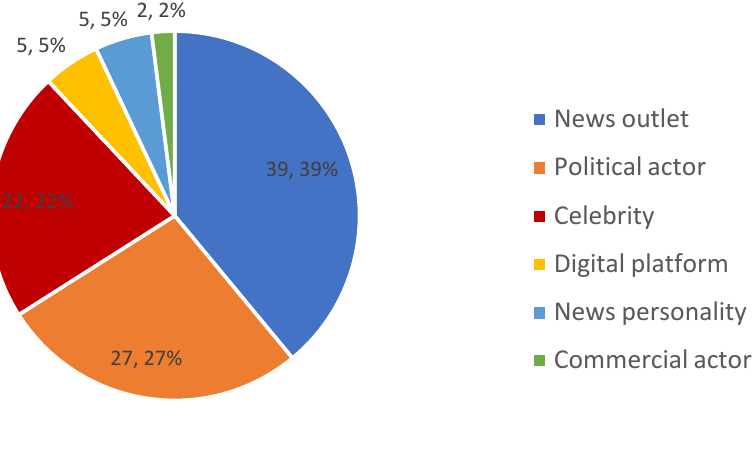
Figure 1: Type of User for the 100 Most Mentioned Users (Source: Authors‘